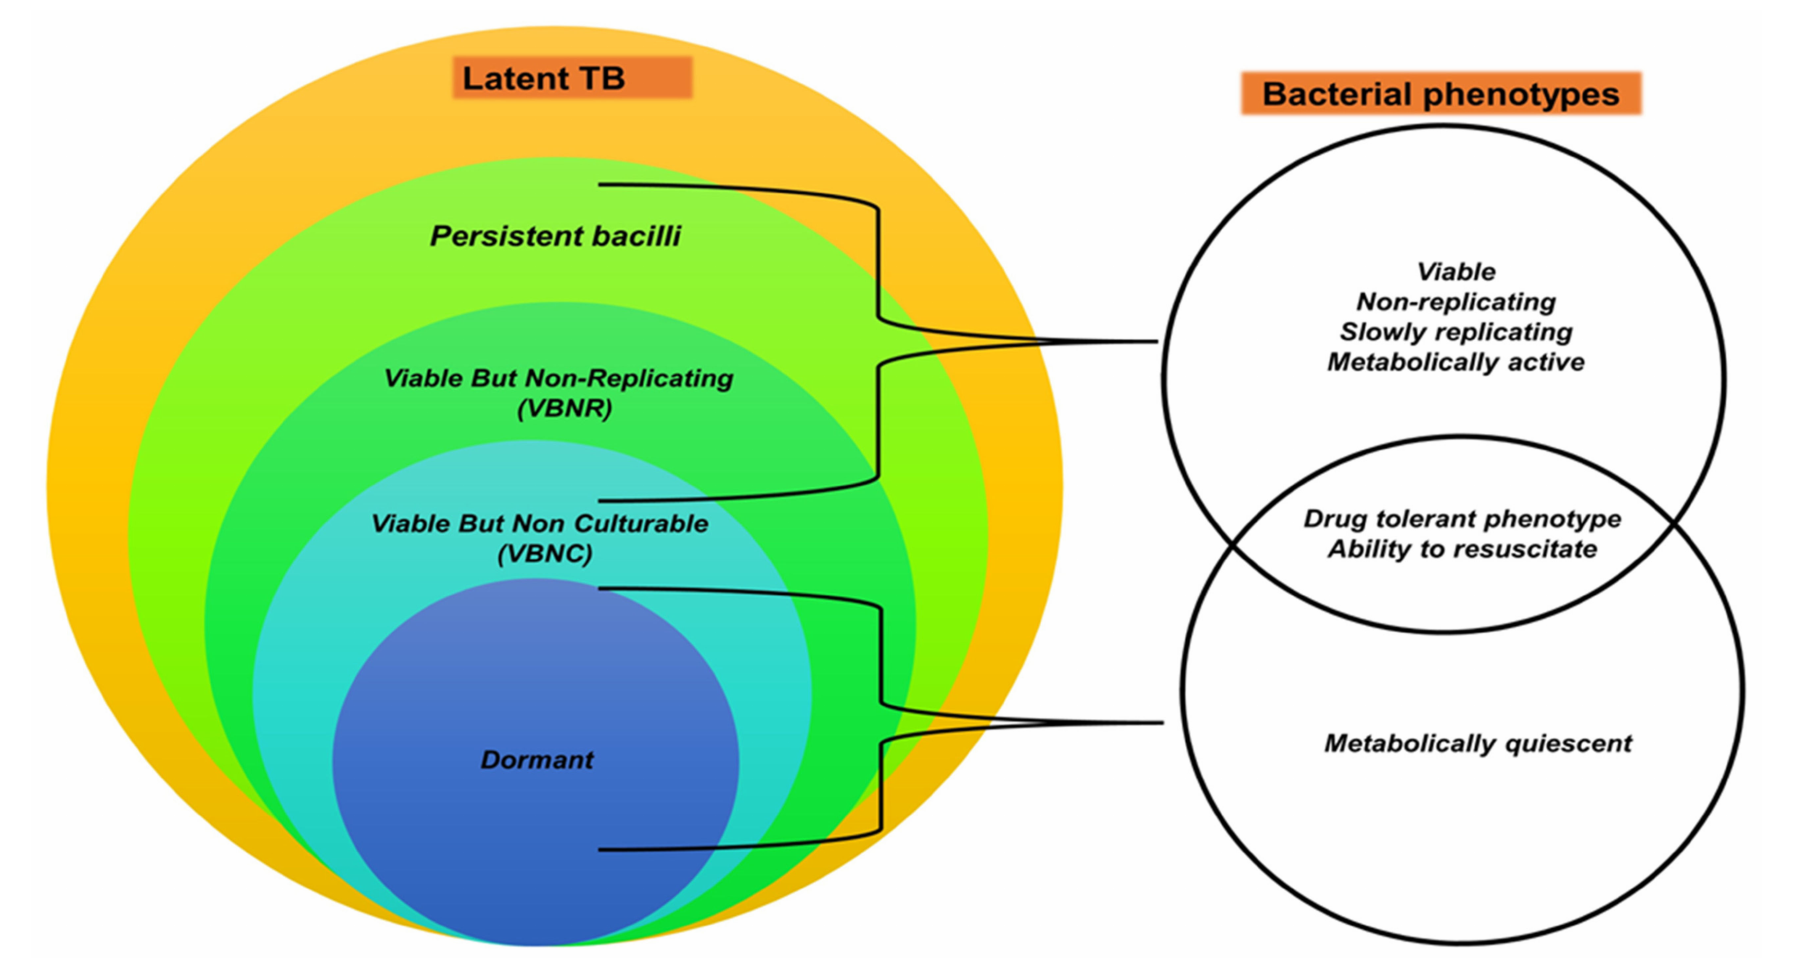
Figure 1. Latent TB stage and underlying bacterial phenotypes. Latent TB is speculated to encompass several bacterial phenotypes, under the broad heading of persister bacteria. The subpopulations of persister bacilli include viable but non-replicating (VBNR) bacilli, viable but non-culturable VBNC bacilli, and dormant bacilli. These have varying phenotypic characteristics and may vary with each TB stage. (Original